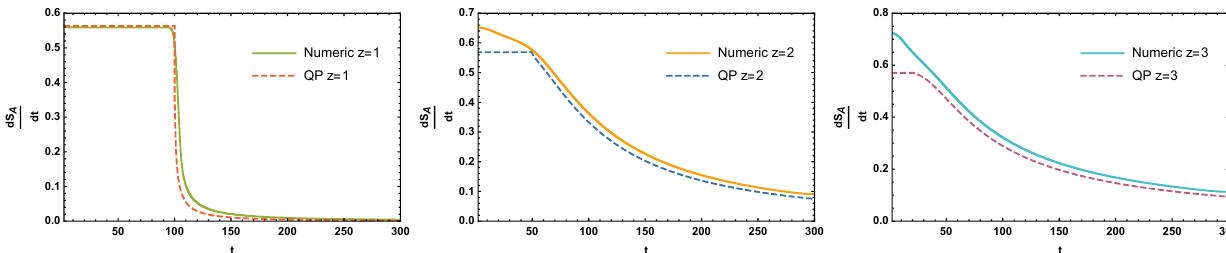
Figure 8 . Numerical versus analytic results for time evolution of EE for z = 1 ; 2 ; 3. Here we set m 0 = 1 and m = 10 (cid:0) 6 . The matching between quasi-particle analytic results and numerics is not as good as the m 0 = 1 and m = 2 case. In this case which tortoise modes are highly occupied, the thermodynamic it is much harder to numerically reach the thermodynamic limit. In these plots we have set the subregion size to be 200 in units of lattice spacing. In this case the di(cid:11)erence between numerics and analytical results at the early times is both due to highly occupation of tortoise modes and also numerical